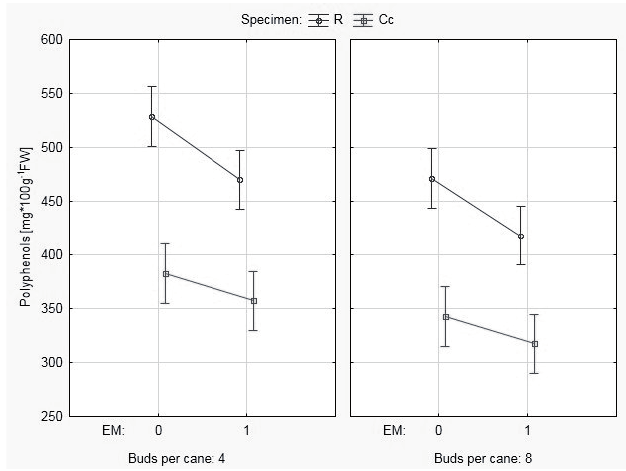
Fig. 1: Effect of the performed treatments on total polyphenol content (in mg 100 g -1 FW) in the fruits of the tested vine